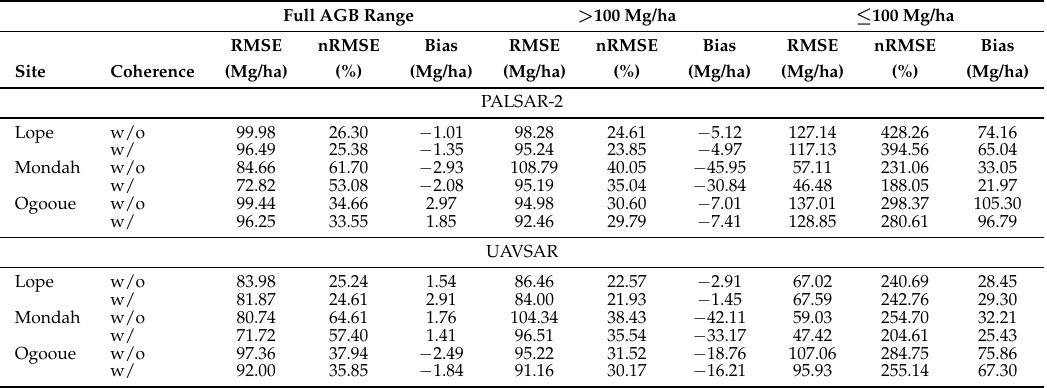
model uses backscatter with (“w/”) and without (“w/o”) coherence. Full AGB